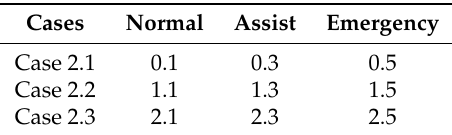
Table 2. Gain setting of each control mode.